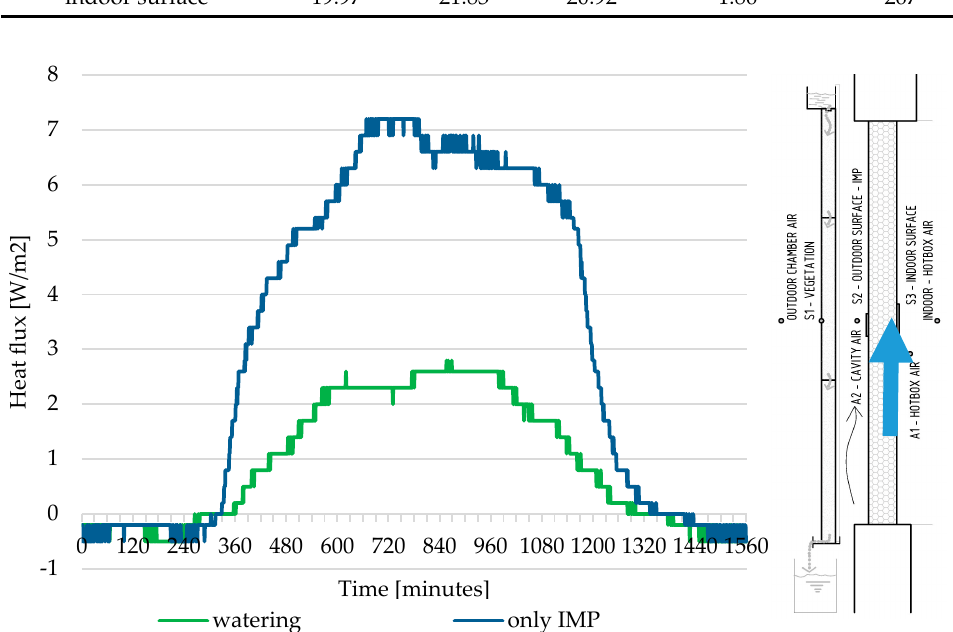
Figure 12. Heat flux courses measured with heat flux plate on the indoor surface (S3). Maximum heat flow only for IMP setup (no cover) is 7.2 W/m 2 and, for VB setup with hourly watering, it is 2.8 W/m 2 .